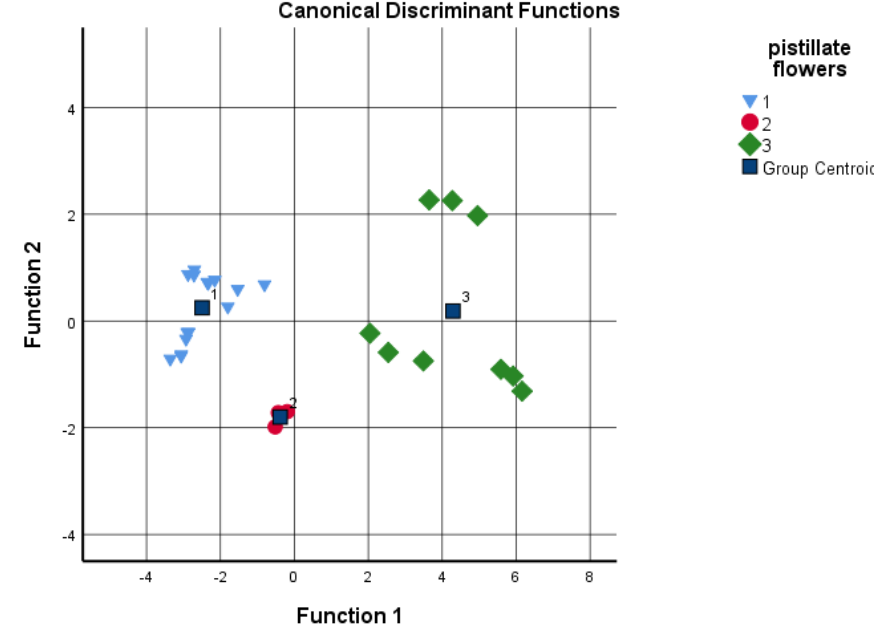
Figure 5. Discriminant analysis by budburst time as a grouping variable; 1 — early: 103 – 104 days; 2 — medium: 107 – 109 days; late: 116 – 120 days (independents: sum of hydroxybenzoic acids, hydroxycinnamic acids, flavonoids and naphthoquinones, as well as juglone concentration).